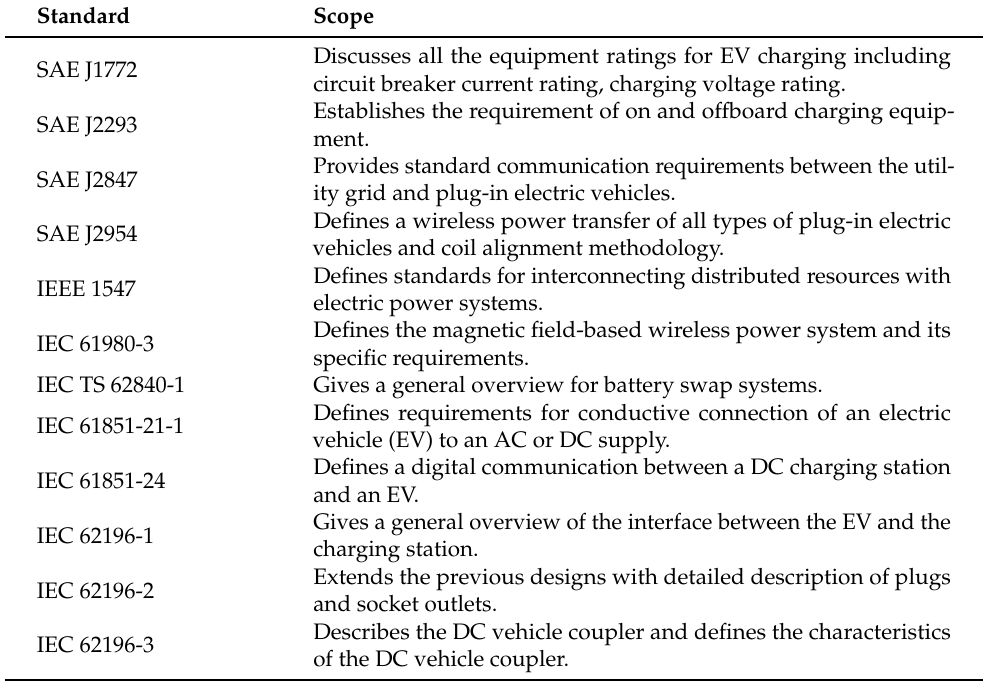
Table 3. Relevant standards for charging stations